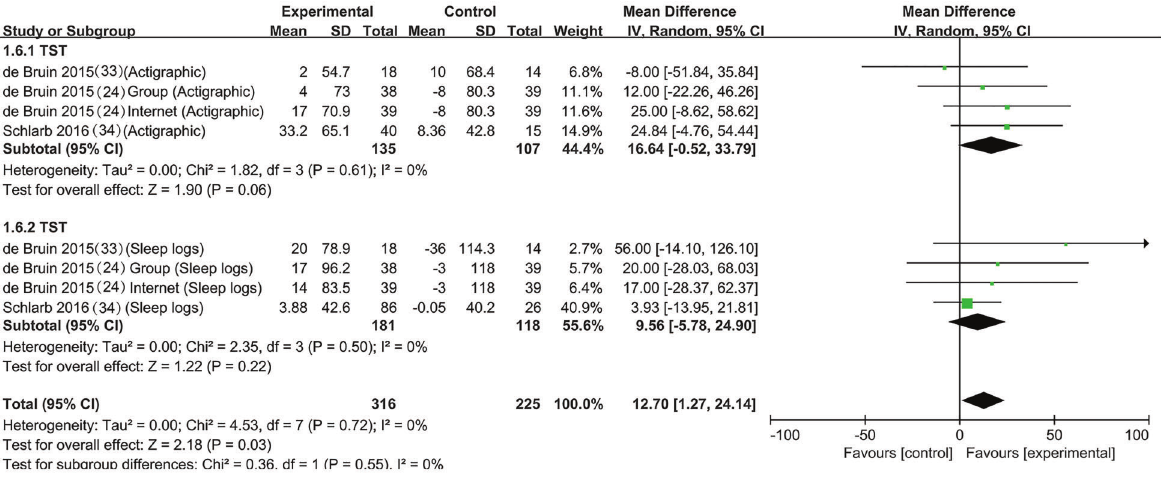
Figure 5. Meta-analysis of the effect of cognitive behavioral therapy for insomnia on total sleep time